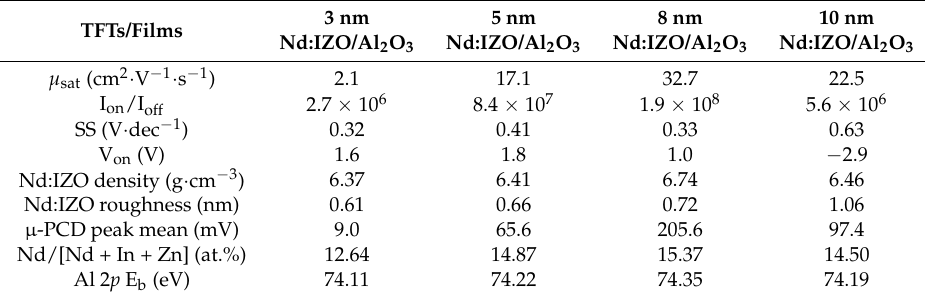
Figure 4. The ( a ) output and ( b ) transfer characteristics of the Nd:IZO/Al 2 O 3 TFTs with different thicknesses of the Nd:IZO layers; ( c ) the film density and roughness for the corresponding Nd:IZO layers. Table 1. A summary of the parameters obtained by the results of electrical measurements and chemical analysis for the Nd:IZO/Al 2 O 3 films and their corresponding TFT devices.